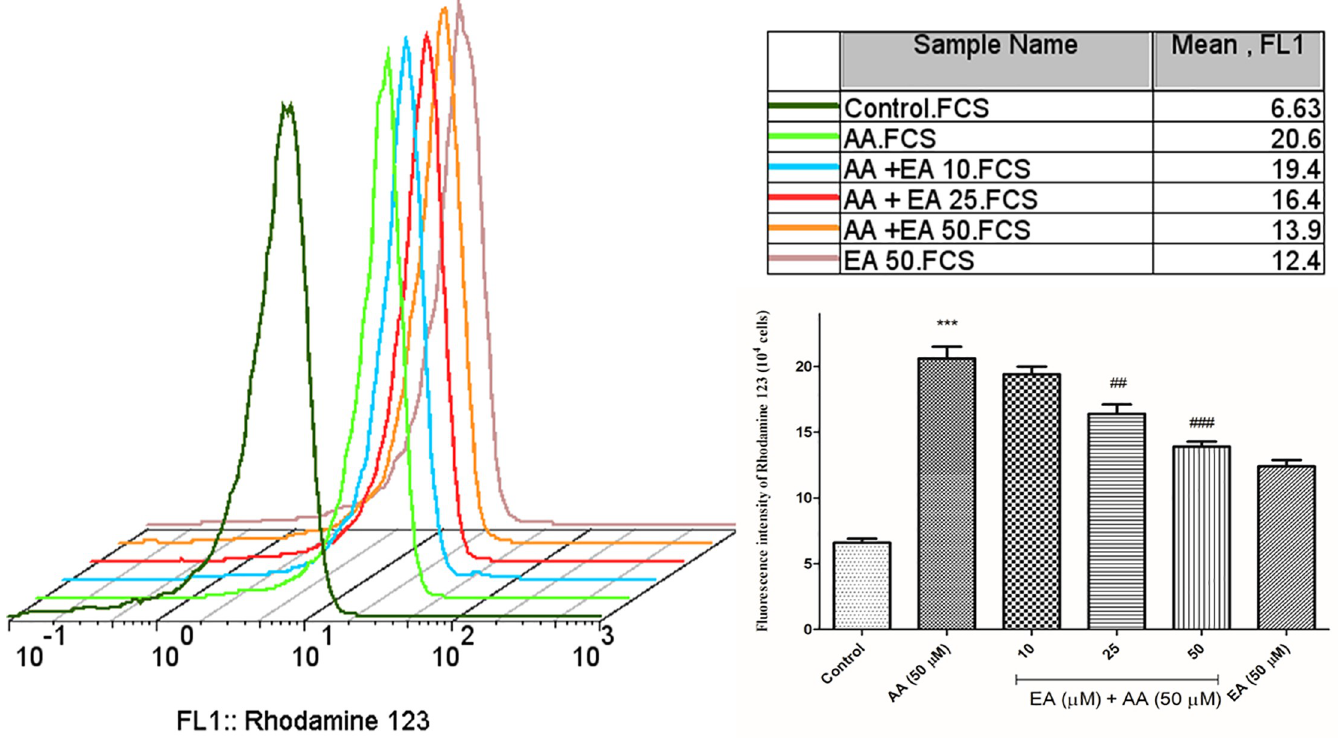
Fig 3. Ellagic acid decreases mitochondrial damages. Mitochondrial membrane potential collapse was analyzed by means of fluorescence intensity of rhodamine 123 as a cationic dye following AA exposure (4 hours) in the presence or absence of EA (10, 25 and 50 μ M) in human lymphocytes. Bar graphs with statistics. Data are presented as mean ± SD, n = 3, independent experiments repeated at least 3 times, ��� p < 0.001: Control versus AA; ##p < 0.01, ###p < 0.001: AA + EA versus AA- treated human lymphocytes ANOVA, Tukey’s